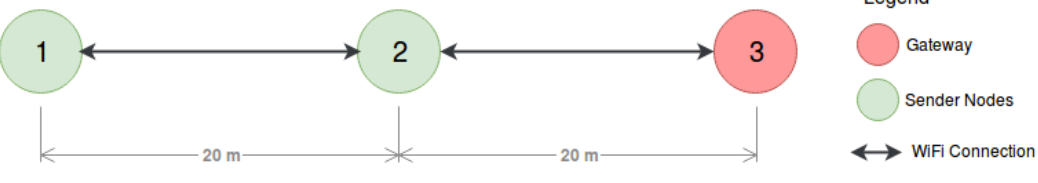
Figure 12. Aquatic Scenario A.